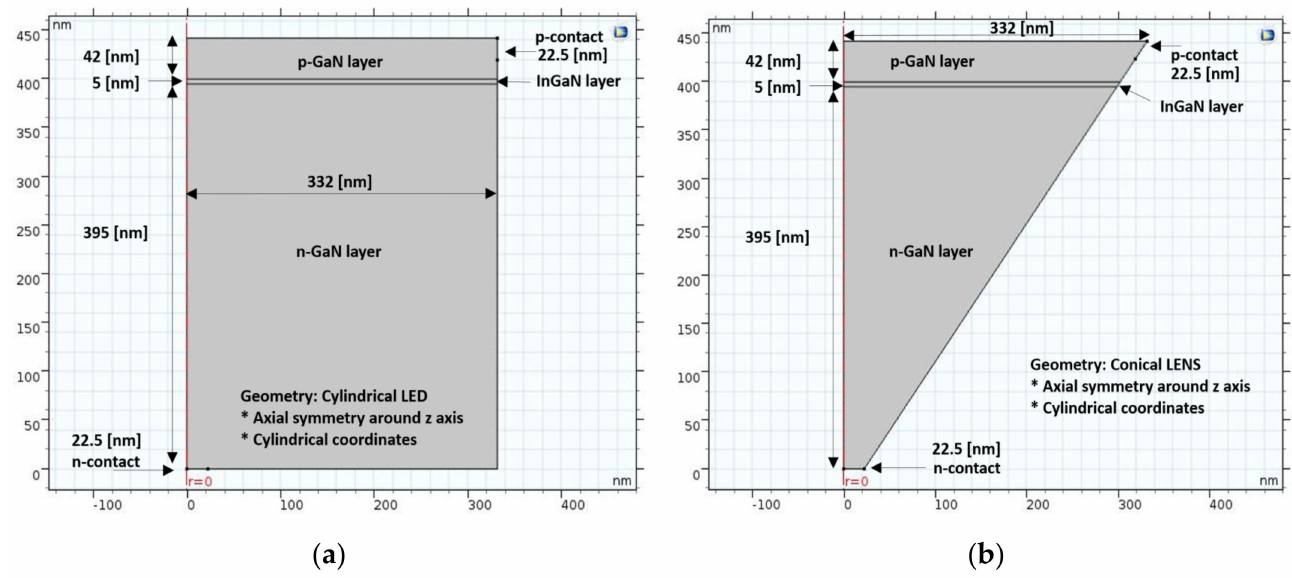
Figure 2. 2D representation of the device structure, with an axial symmetry around the z-axis, and using cylindrical co-ordinates. ( a ) Cylindrical shape (regular device); ( b ) conical shape (LENS device).